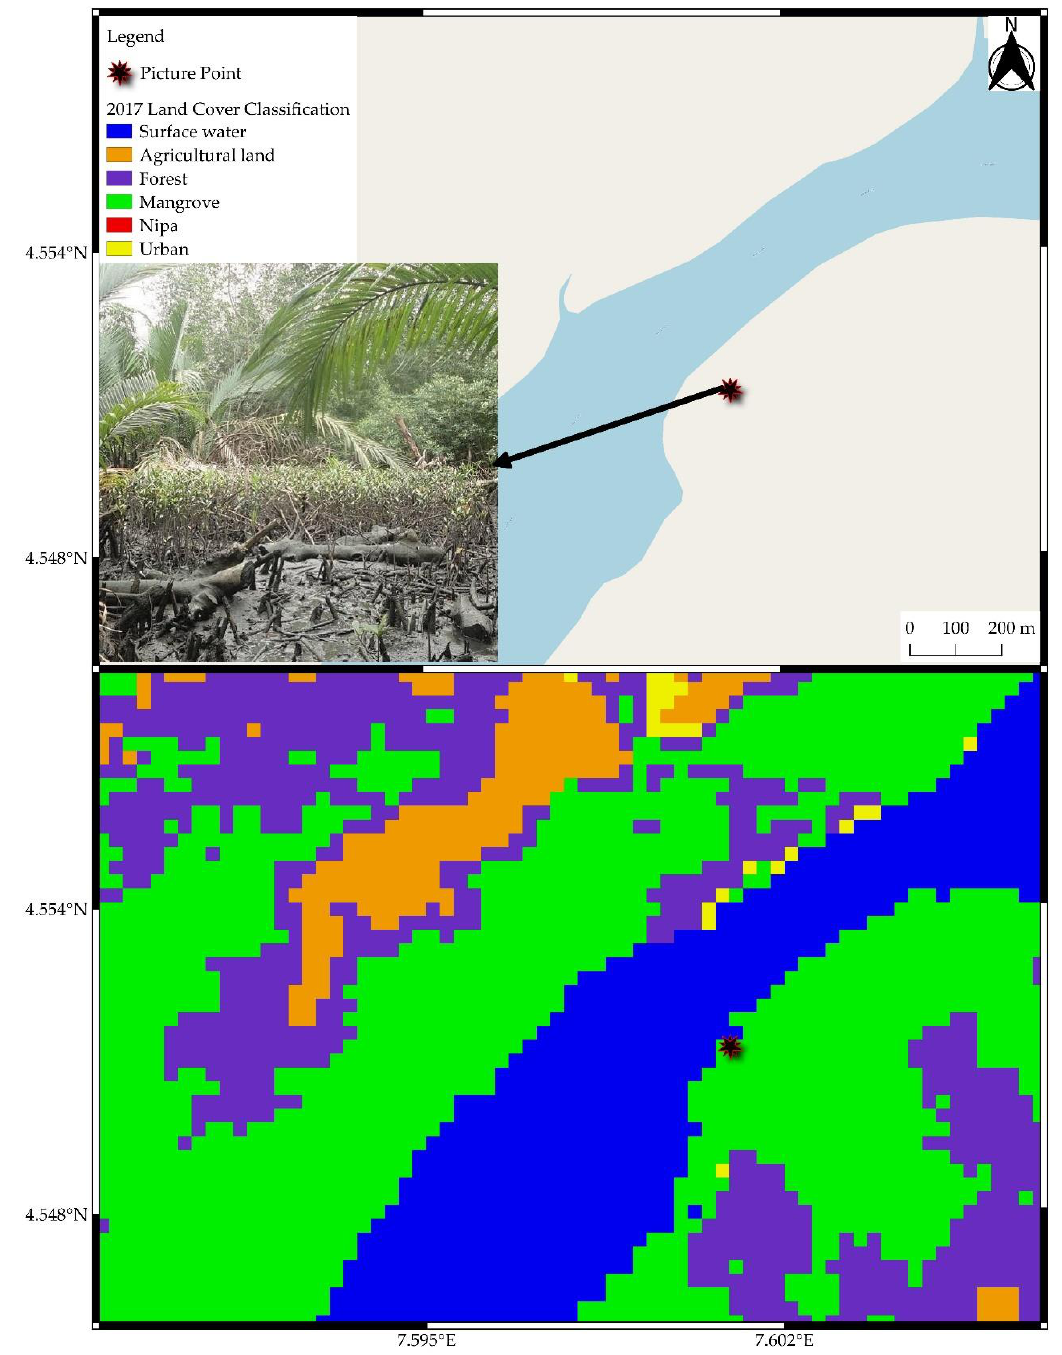
Figure 9. Mixed stand of Nipa Palm and disturbed mangrove in Ete Figure 9: Mixed stand of Nipa Palm and disturbed mangrove in Ete creek.